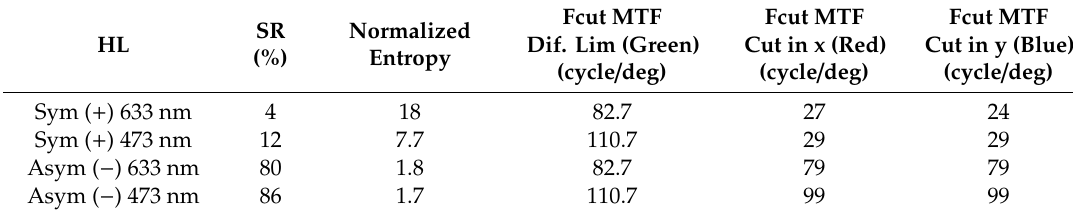
Table 4. Image quality based on impulse response and Fourier domain.